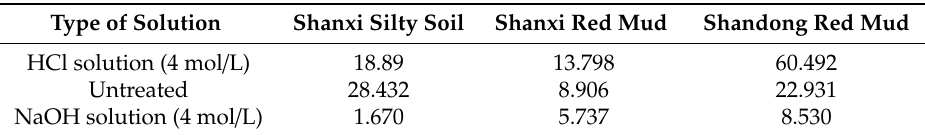
Table 3. The specific surface areas of soil samples immersed in HCl or NaOH solution (m 2 / g). Type of Solution Shanxi Silty Soil Shanxi Red Mud